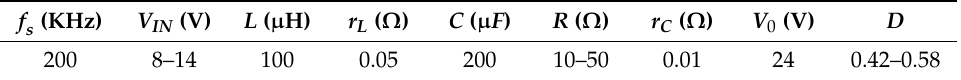
Figure 1. Boost converter circuit. Table 1. Boost converter parameter values and